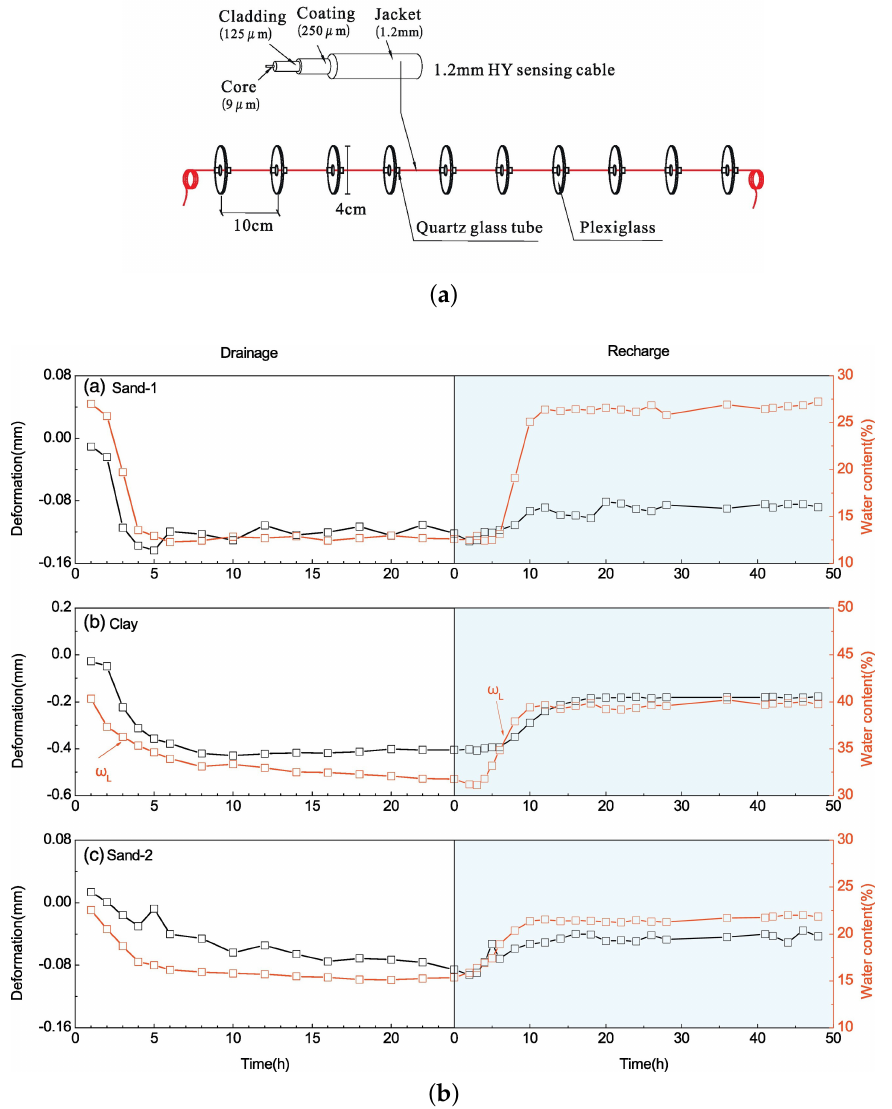
Figure 21. ( a ) Sensing cable used for measuring soil strain during a drainage–recharge cycle, with vertically deployed fibres; ( b ) Time variation of water content and displacements, measured using a BOTDA scheme, during the drainage and recharge cycle for different soils. Reproduced with permission from